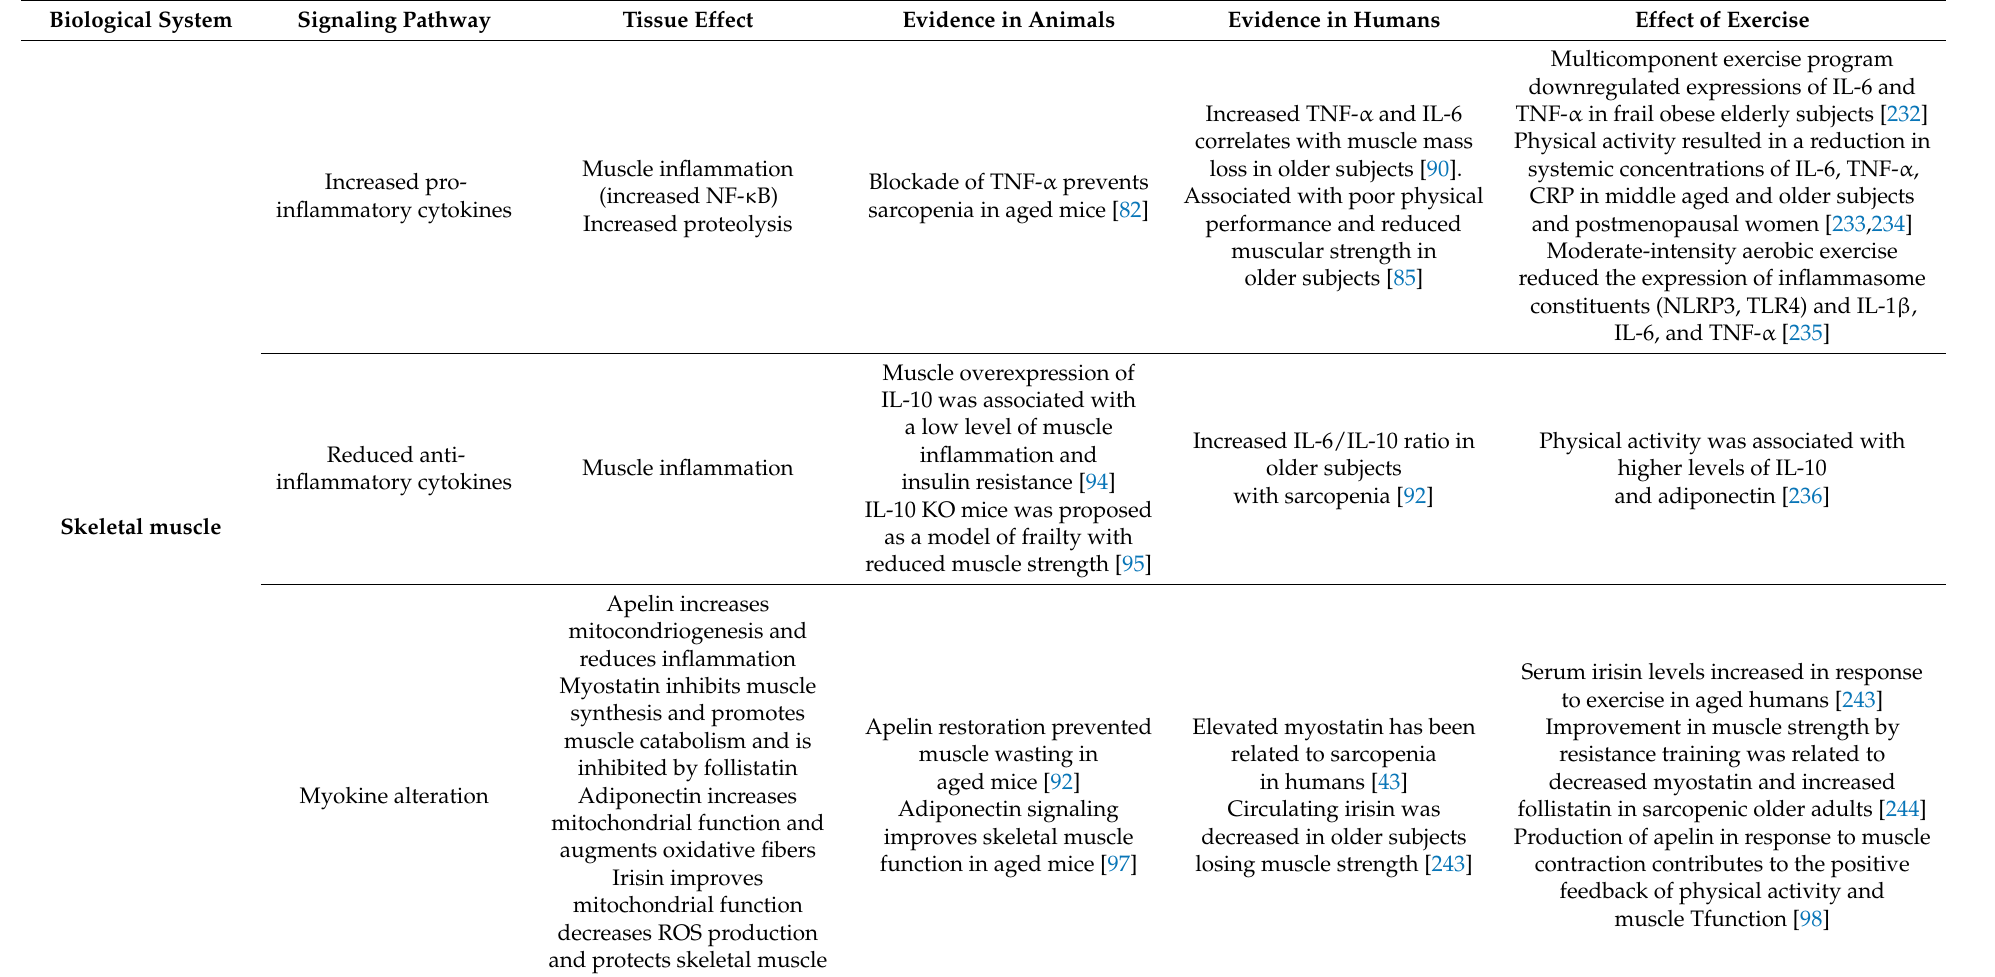
Table 2. Inflammation-related pathways influenced by aging and